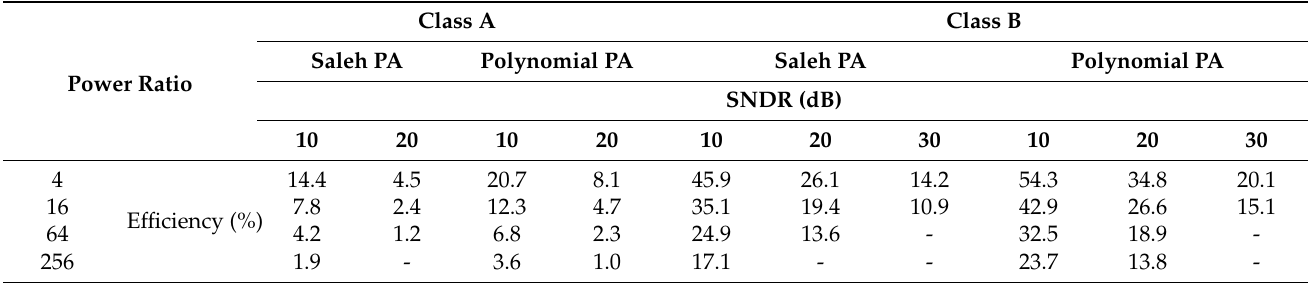
Table 1. Efficiency of different PAs with different values of SNDR and power